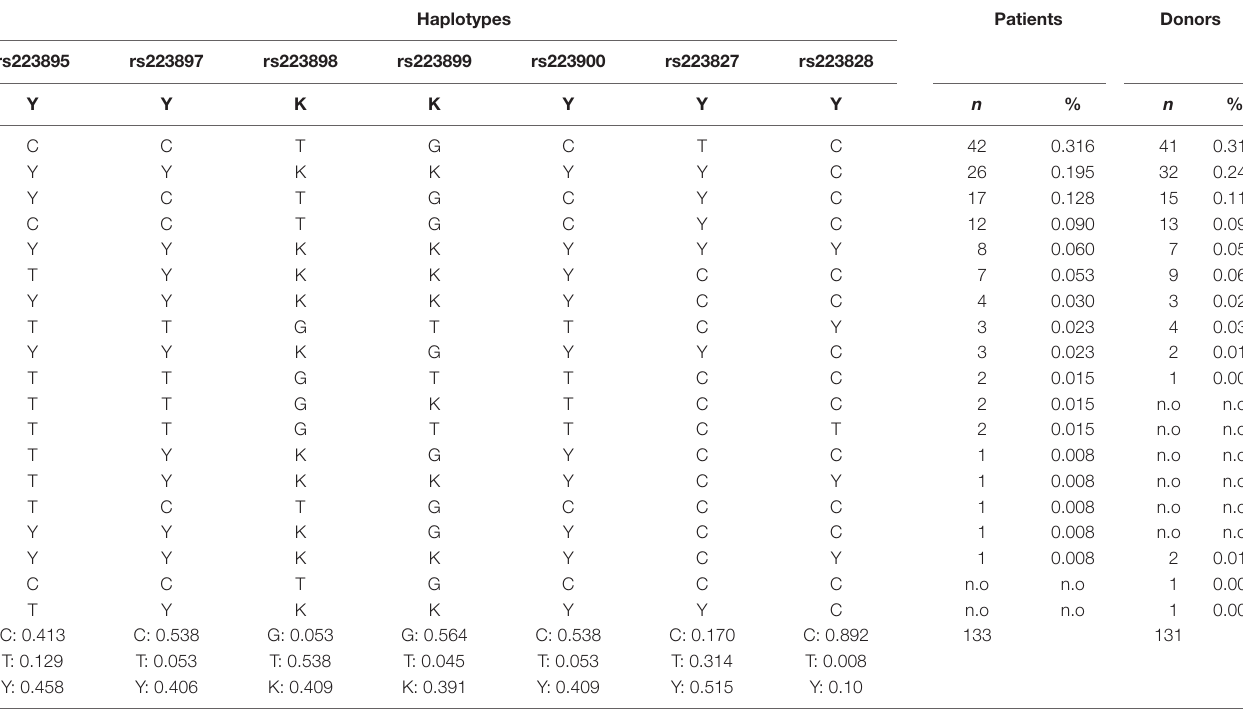
Table 2 | Genetic configuration of selected TARC/CCL17 promotor